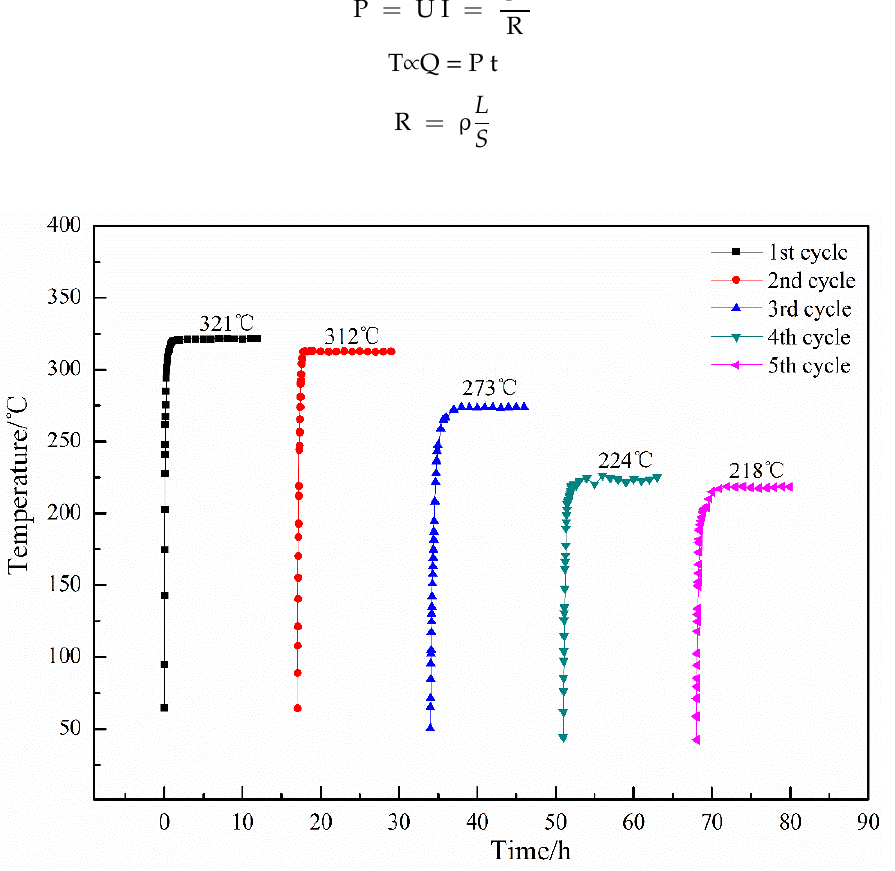
Figure 7. Temperature–time curves of electrical-heating coating cyclic electrification tests.